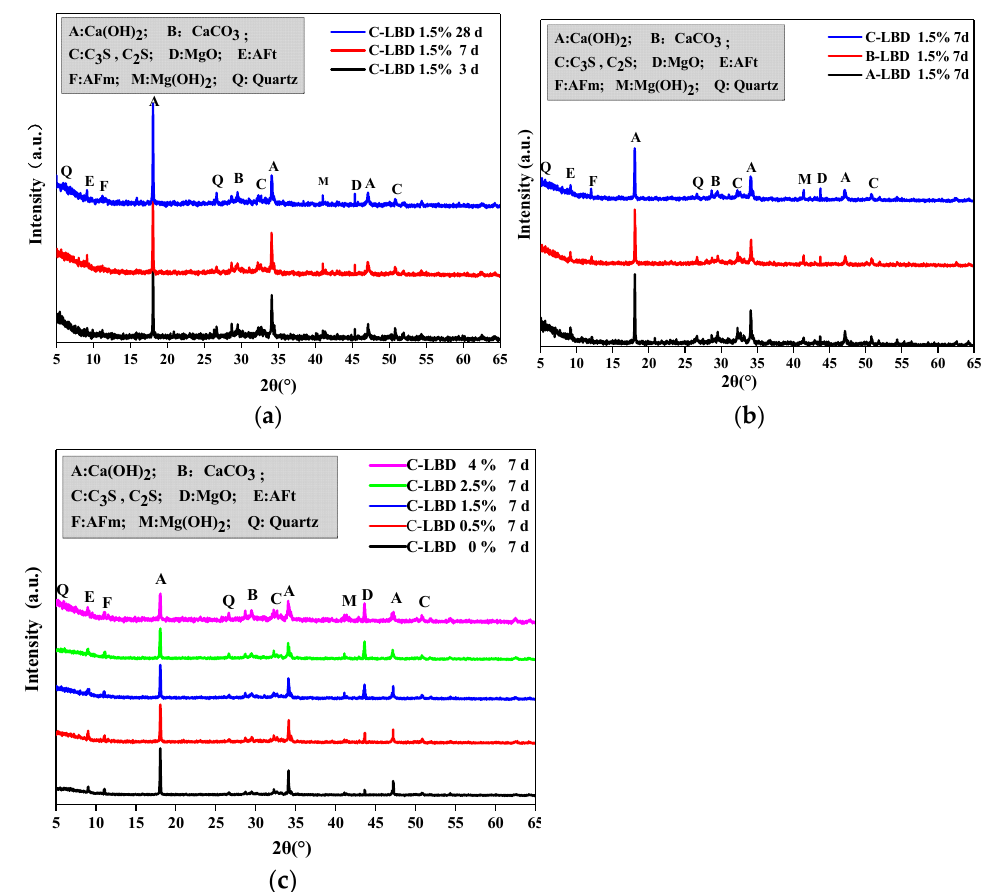
Figure 7. XRD diffractograms LBD/OPC pastes: ( a ) Influence of time; ( b ) influence of fineness; ( c ) influence of dosage.